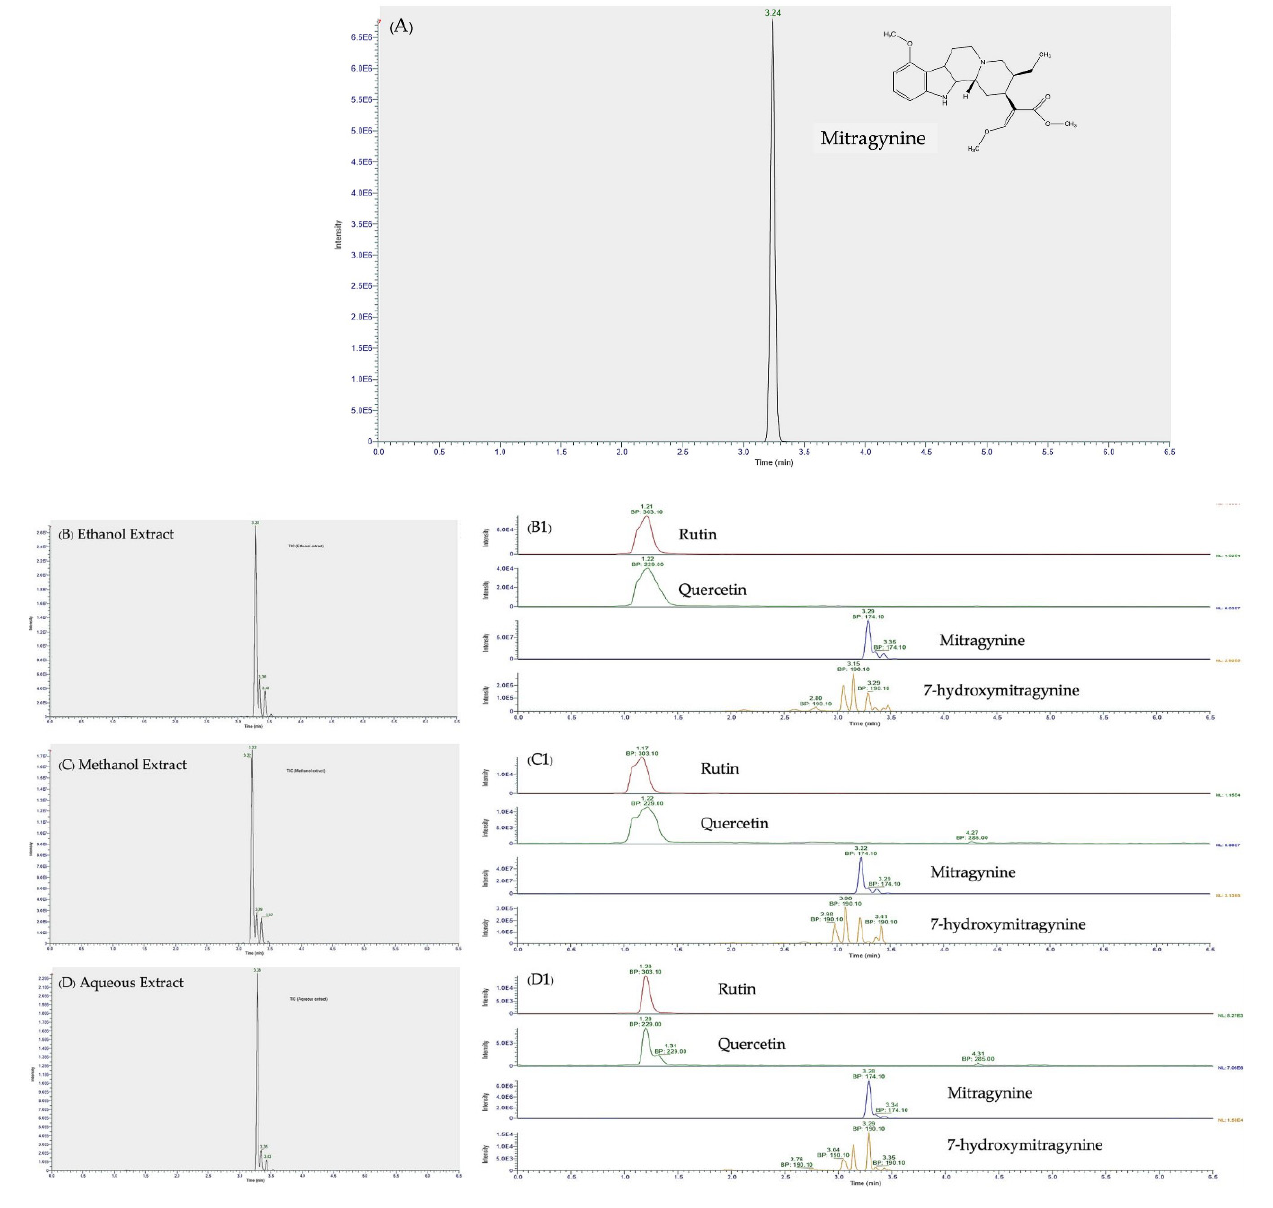
Figure 2. Total ion chromatograms (TIC) from LC-MS/MS of ( A ) the reference standard (mitragynine) concentration at 1 µ g/mL, ( B ) ethanol extract, ( C ) methanol extract, and ( D ) aqueous extract from kratom leaves. The peaks of four major constituents were identified by comparison with the refer- ence standards, their retention times, and mass fragmentation patterns ( B1 – D1 ) as rutin, quercetin, mitragynine, and